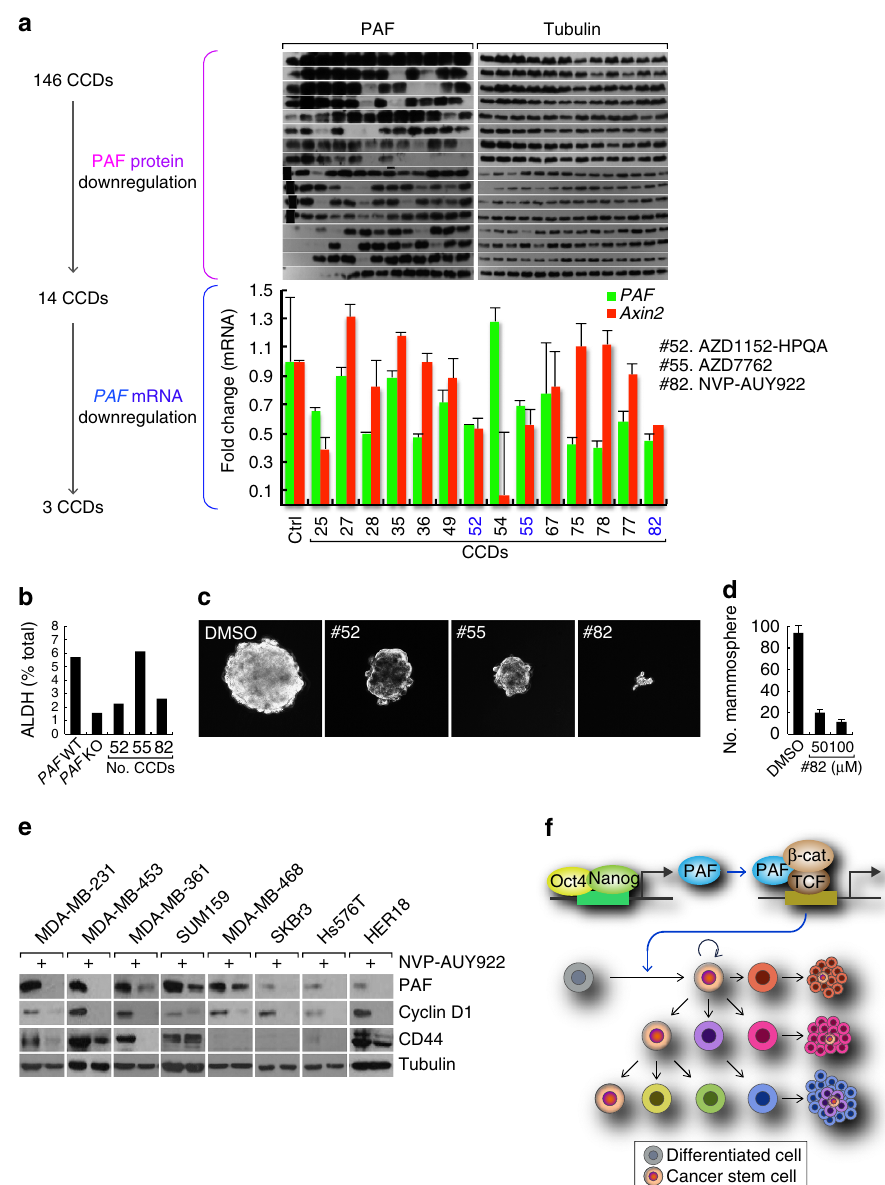
Figure 7 | Identification of clinical cancer drugs targeting PAF. ( a ) Total 146 CCDs were treated in HER18 cells (1 m M; 24h) for screening potential PAF inhibitors. Fourteen CCDs downregulating PAF protein are identified by IB assays. Next, among 14 CCDs, 3 CCDs (blue) were selected by their inhibitory effects on PAF and AXIN2 transcription using quantitative reverse transcriptase–PCR (qRT–PCR). Error bars ¼ s.e.m. ( b ) Decreased ALDH activity by CCDs. HER18 cells were treated with three CCDs (100nM; 24h) and analysed for ALDH activity using FACS. HER18 PAF KO cells served as a negative control. Diethylaminobenzaldehyde (DEAB)-treated cells were also tested as a negative control (data not shown). ( c , d ) Decrease in mammosphere formation by NVP-AUY922. Phase-contrast images ( c ) and quantification of the number of mammosphere ( d ). Error bars ¼ s.e.m. ( e ) Downregulation of b -catenin target genes by NVP-AUY922. Breast cancer cell lines were treated with NVP-AUY922 (100nM, 36h) and analysed by IB assays. ( f ) Illustration of working model: PAF-Wnt signalling axis in breast cancer cell